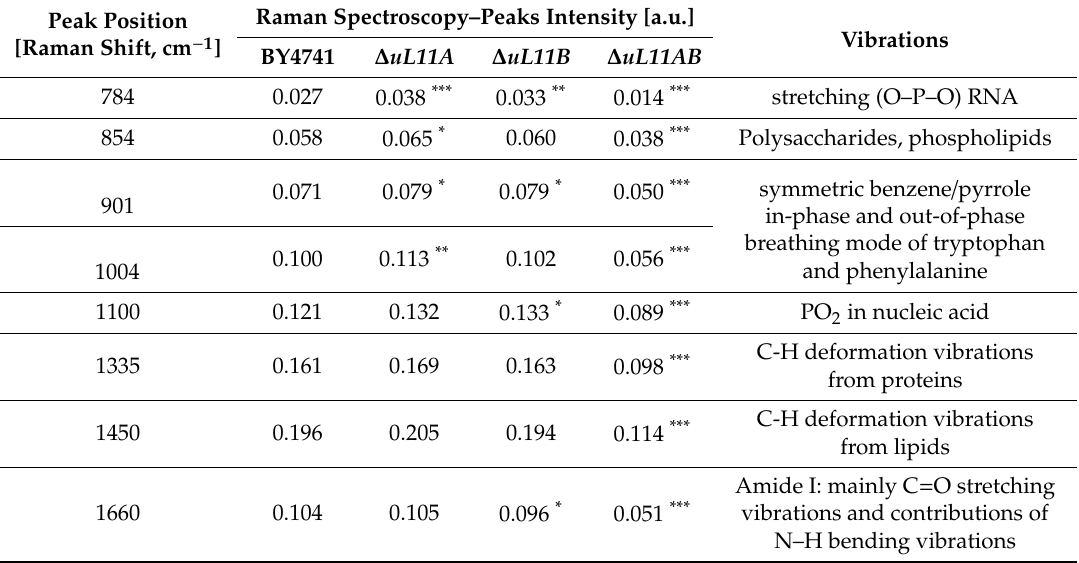
Table 2. Raman spectroscopy analysis. The individual peak values and their intensity in the analyzed yeast cultures are provided with description of vibrations corresponding to the respective functional groups [44–48]. The data presented are the average values of eight independent repetitions for each object. The significance of the intensity of Raman peaks relative to the yeast being the genetic background (BY4741) was determined using a one-way ANOVA and Tukey’s HSD test procedure at the level of significance: p ≤ 0.0005 (***), p ≤ 0.005 (**), and p ≤ 0.05